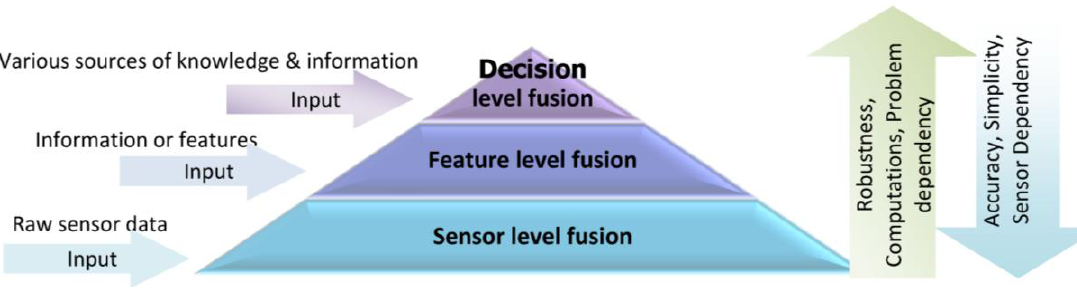
Figure 1. Multi-level sensor fusion